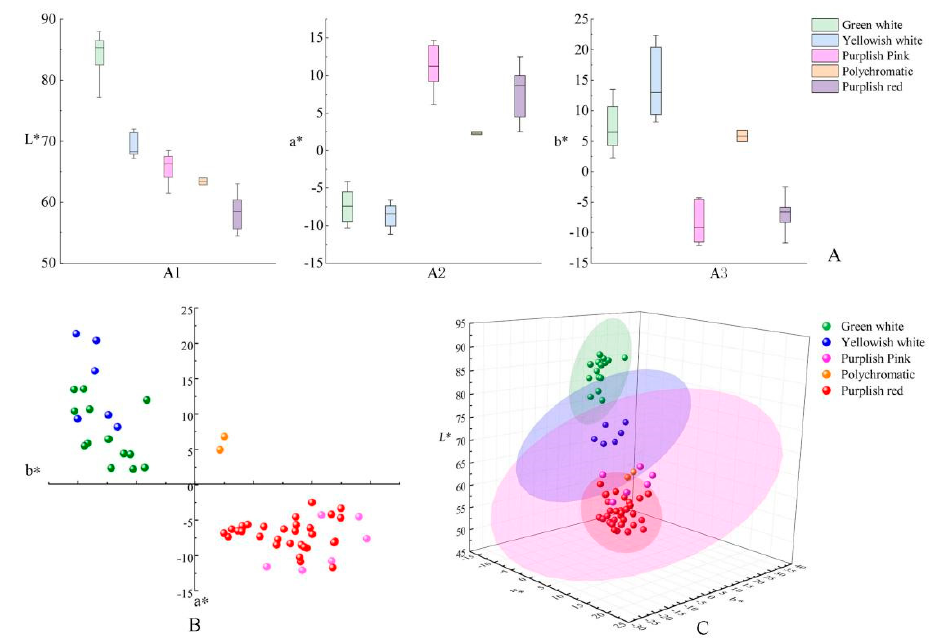
Figure 4 . The box plot, 2D and 3D distribution diagram of L *, a* and b* values of different color groups of L. chinense var. rubrum . Note: ( A ) The box plot of L* , a* and b* values, A1 box plot of L* value for different color groups; A2 box plot of a* value for different color groups; A3 box plot of b* value for different color groups. ( B ) The 2D distribution diagram of L* , a * and b* values of different color groups. ( C ) The 3D distribution diagram of L* , a* and b* values of different color groups.